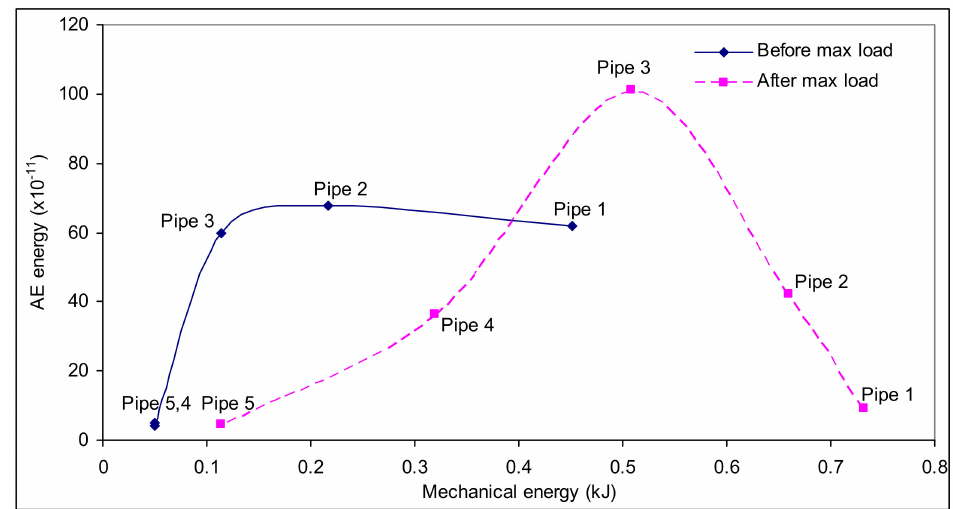
Figure 9. AE energy and mechanical energy before and after maximum load.